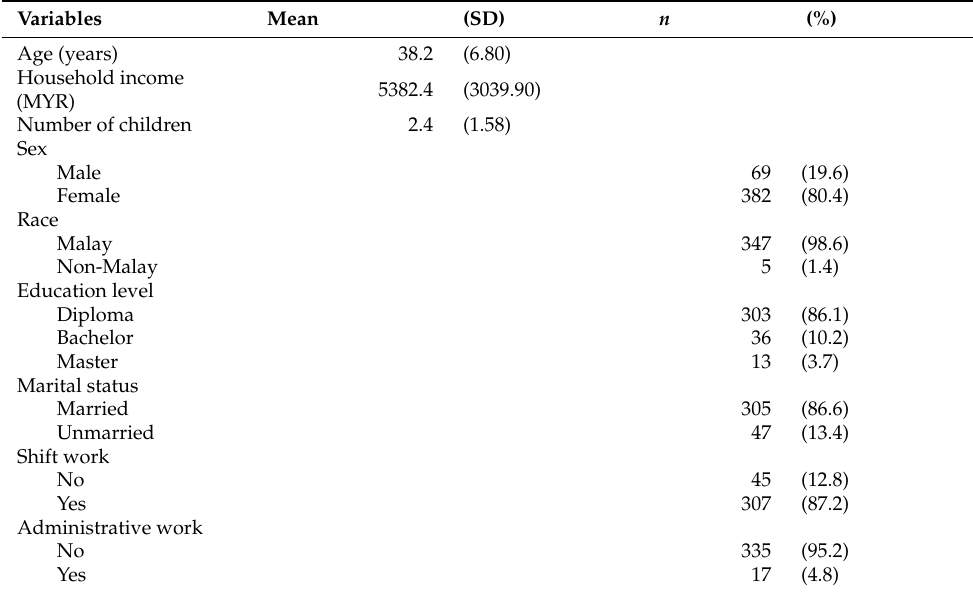
Table 1. Sociodemographic characteristics of participants ( n = 352).